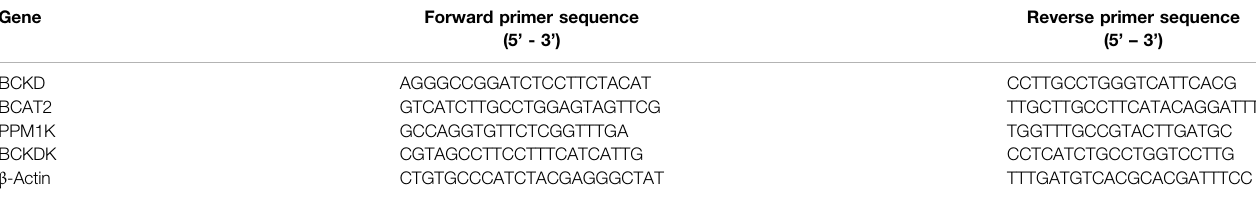
TABLE 1 | Primer sequences in real-time